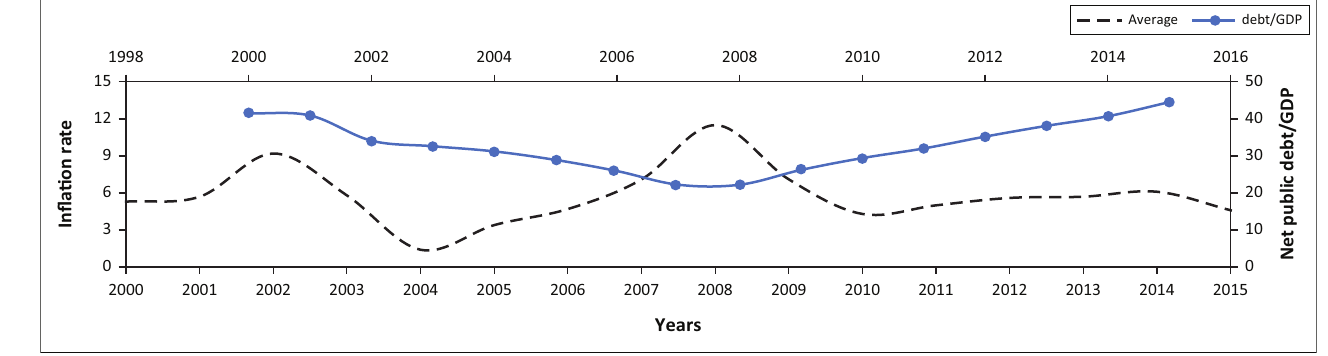
FIG URE 1: Inflation rate versus public debt–gross domestic product ratio,